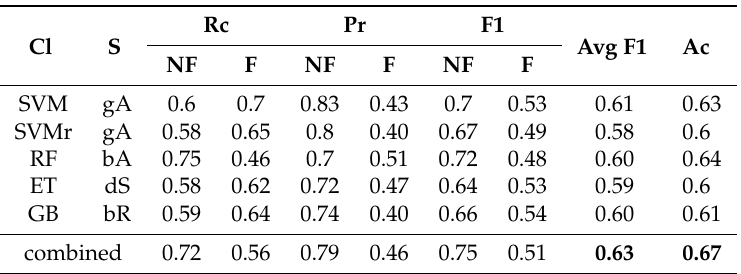
Table 3. Average Classification results across all folds for different classifiers. The S column indicates the EEG feature stream that provided the best results after the exhaustive grid search analysis on all the collected EEG signals (see Section 4.2.1). In last row we show the best results achieved by combining the predictions of all the trained models. Values in bold correspond to the methods that provided the best and more stable results. The abbreviations of Table 3 are the following: Cl: Classifier, S: Signal, Pr: Precision, Rc: Recall and Ac: